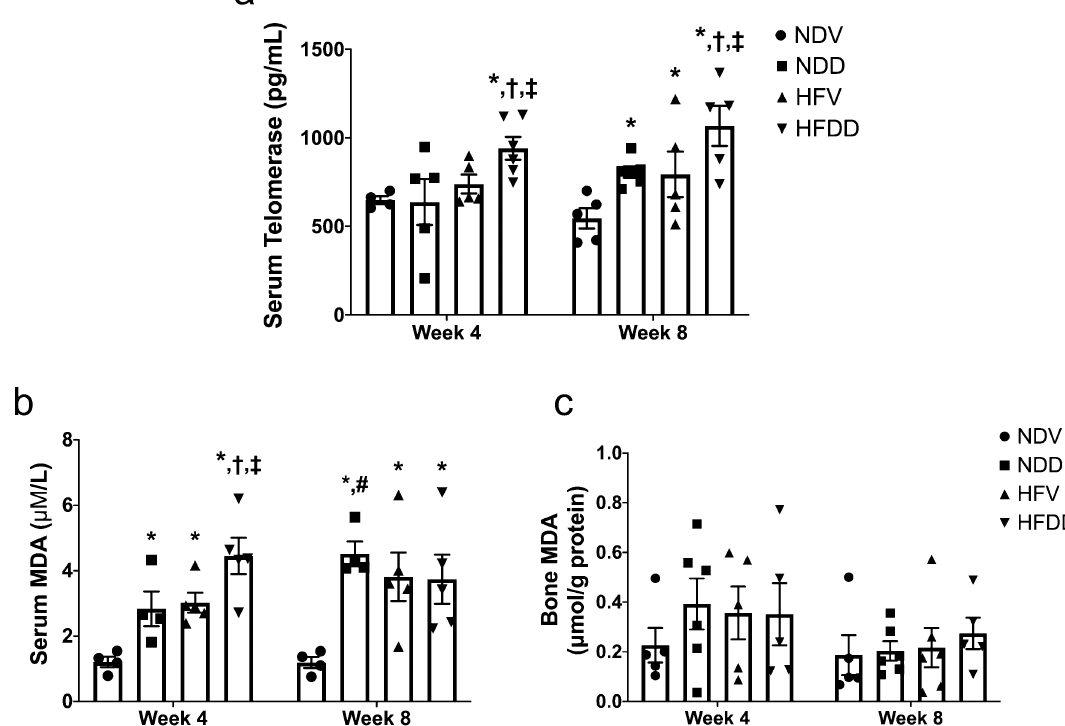
Figure 2. D-galactose-induced aging aggravated systemic oxidative stress in the obese-insulin resistant condition. ( a ) Levels of telomerase in serum at the indicated time points, ( b ) Levels of MDA concentration in serum at the indicated time points, ( c ) Levels of MDA concentration in skeletal tissue at the indicated time points. Bar graphs presented as mean ± SEM (n = 4–6/group). * p < 0.05 versus NDV at the same time point, † p < 0.05 versus NDD at the same time point, ‡ p < 0.05 versus HFV at the same time point, # p < 0.05 versus same group at the different time point. HFDD, high-fat diet with D-galactose; HFV, high-fat diet with vehicle; MDA, Malondialdehyde; NDD, normal diet with D-galactose; NDV, normal diet with